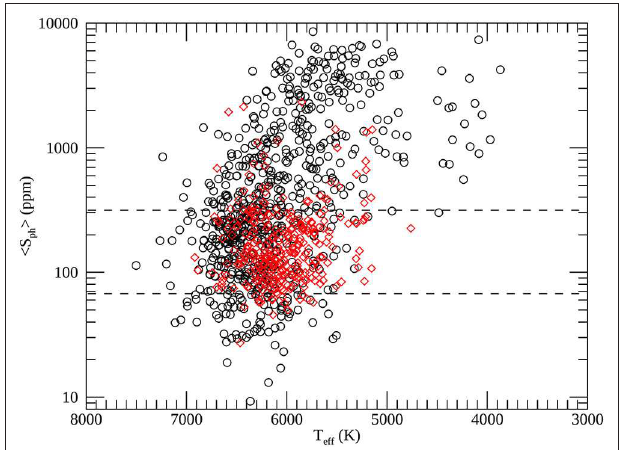
FIGURE 13 | < S ph > as a function of the effective temperature from the DR25 stellar properties catalog. Same legend as Figure 9 .